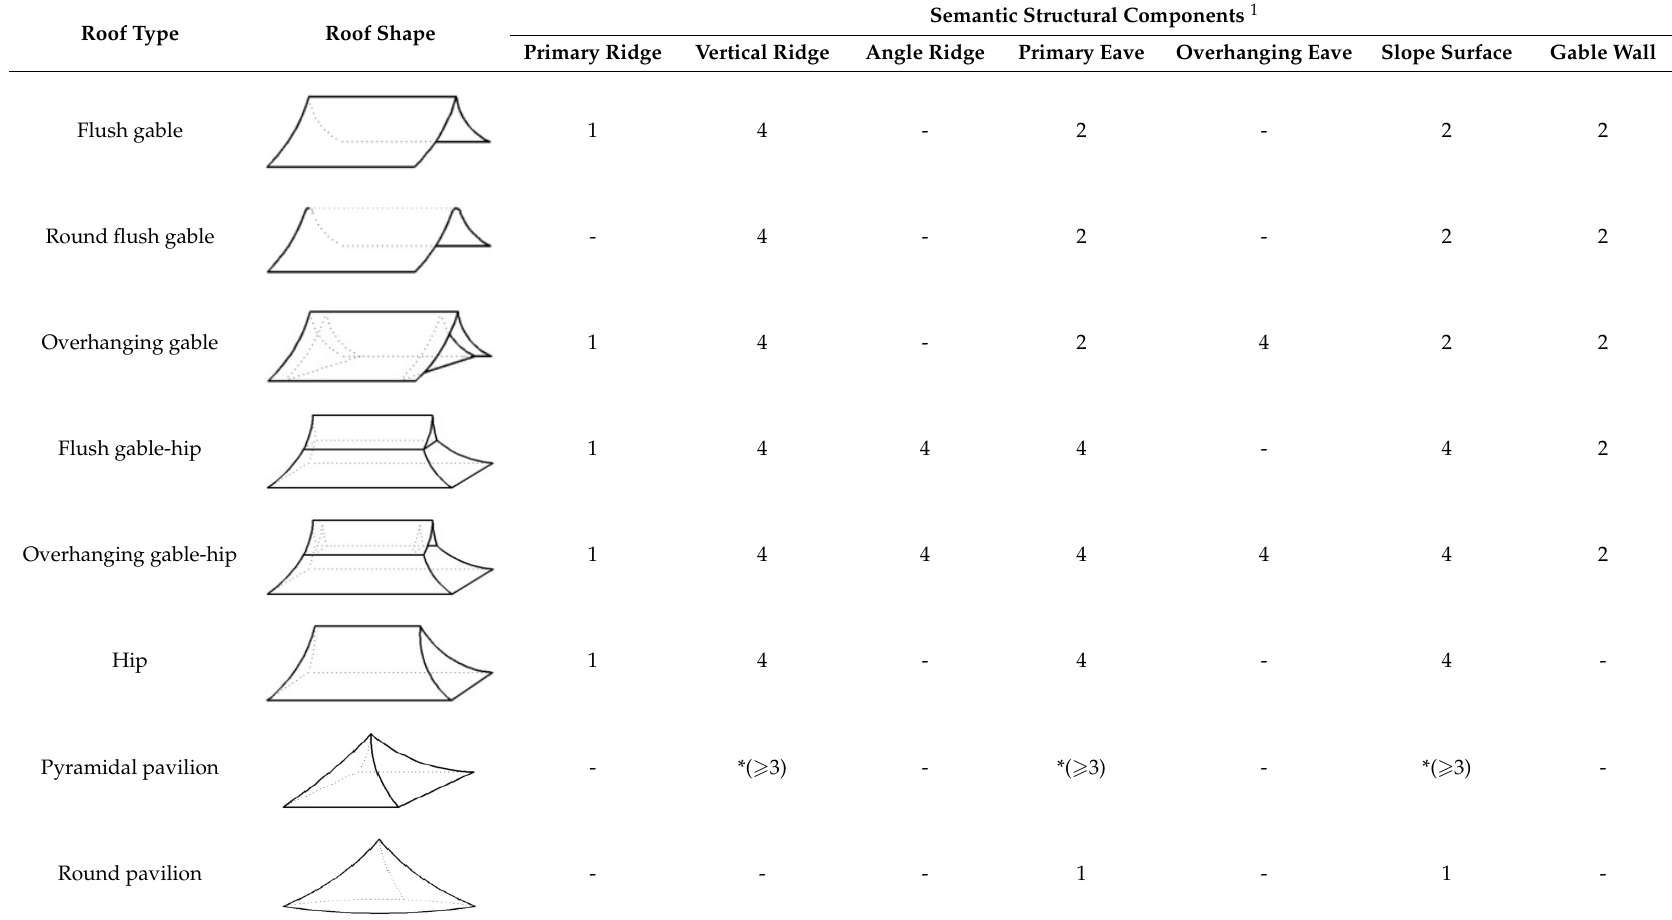
Table 1. Eight representative roof types and their semantic